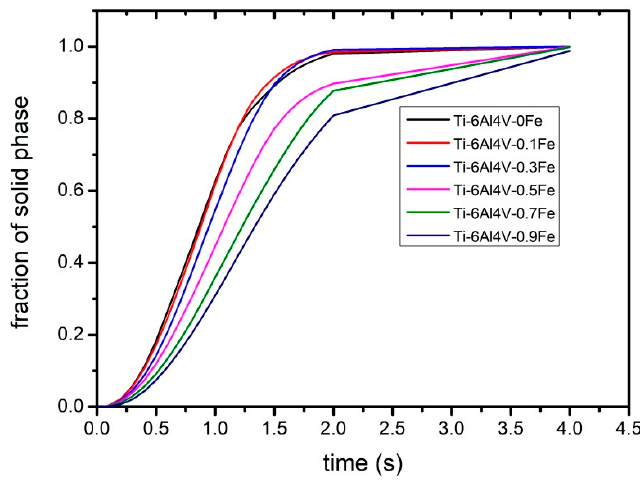
Figure 6. E ff ect of Fe content on grain growth Figure 6. Effect of Fe content on grain growth rate.